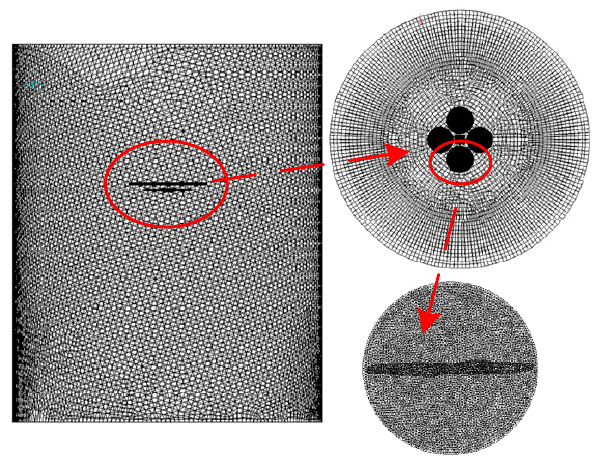
Figure 5. Mesh distribution.